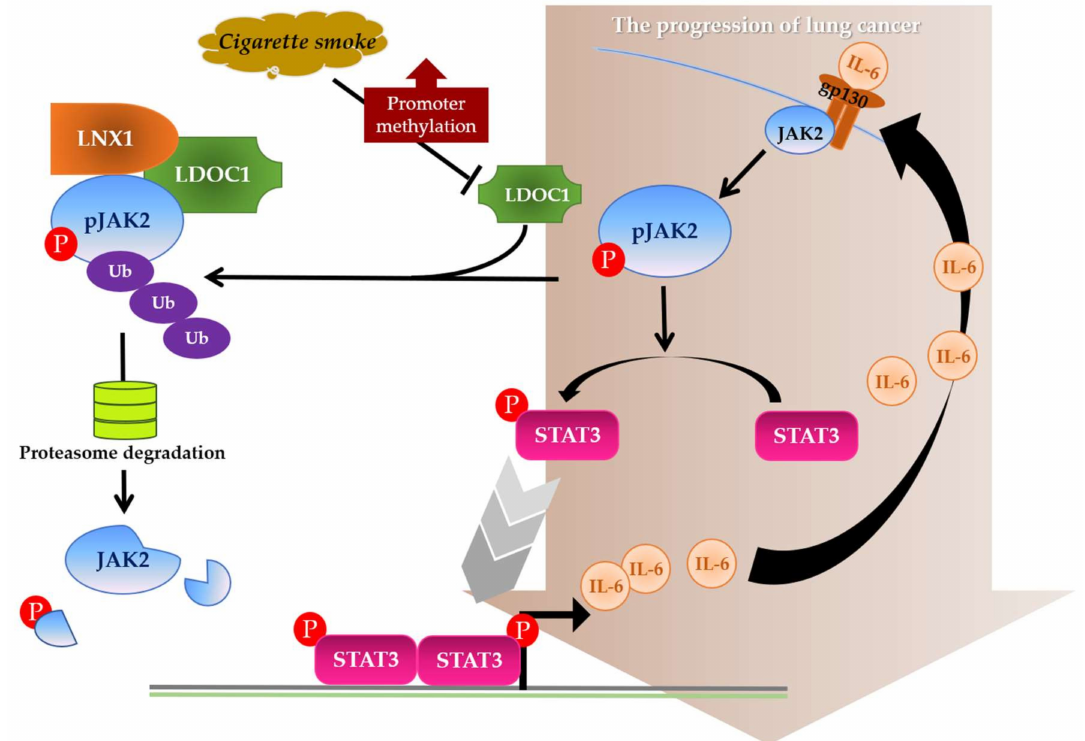
Figure 7. Model outlining the role of LDOC1 as a cigarette smoke-sensitive negative regulator of IL6/JAK2/STAT3 in lung cancer. LDOC1 functions as an adaptor between pJAK2 and E3 ligase LNX1. After cigarette smoke exposure, LDOC1 expression was downregulated or silenced by promoter hypermethylation, which led to inefficient ubiquitination of pJAK2 because a LNX1–pJAK2 complex could not form. Accumulated pJAK2 activated STAT3 through phosphorylation of STAT3 Y706 . pSTAT3 Y706 translocated to the nucleus, where it regulated the expression of target genes such as IL-6. At an increased concentration, IL-6 bound to cell-surface receptor gp130, resulting in the phosphorylation of JAK. In this manner, LDOC1 knockdown drove lung cancer progression by reinforcing the IL6/JAK2/STAT3 signaling